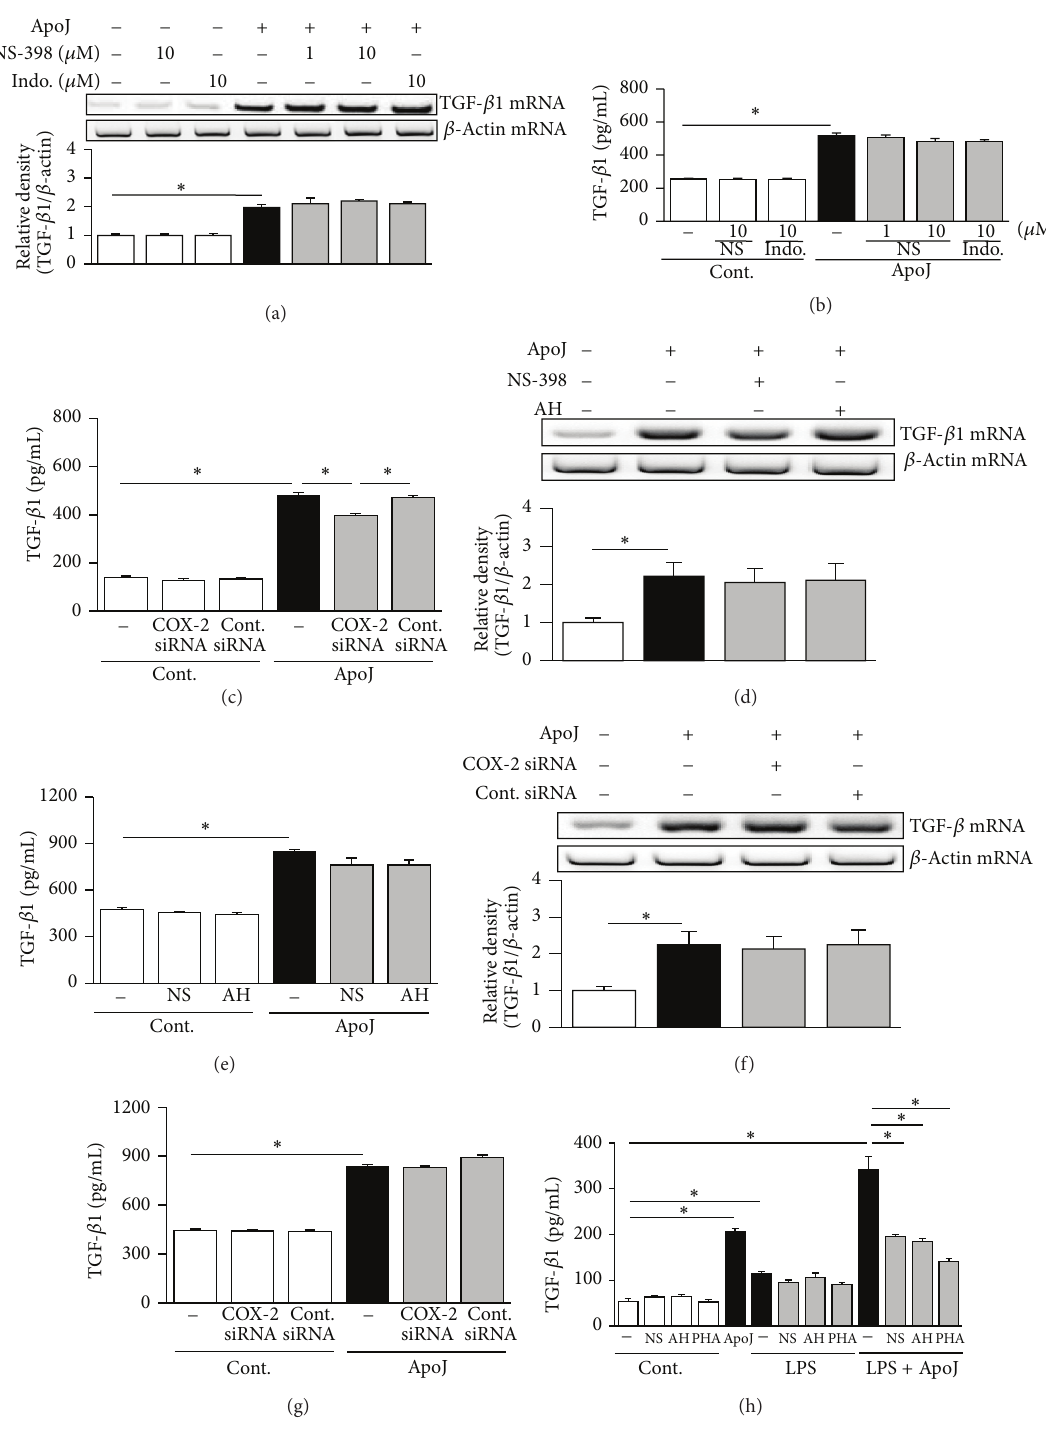
Figure 8: TGF- 𝛽 1 induction in unstimulated macrophages in response to apoptotic cells is not notably suppressed by COX-2 inhibition. RAW 264.7 cells (a, b) or peritoneal macrophages (d, e) were pretreated with NS-398, indomethacin (Indo), or AH-6809 (AH) for 1h and then stimulated with apoptotic Jurkat cells (ApoJ) for 2 h to detect TGF- 𝛽 1 mRNA expression (a, d) or for 24 h to detect secreted TGF- 𝛽 1 (b, e). RAW cells (c) or peritoneal macrophages (f, g) were transfected with COX-2 siRNA or control vehicle (siRNA-GFP) for 6h and then stimulated with ApoJ for 2h to detect TGF- 𝛽 1 mRNA expression, or for 24 h to detect secreted TGF- 𝛽 1. (h) Raw cells were pretreated with 10 𝜇 M NS-398, 10 𝜇 M AH-6809, or 10 𝜇 M PHA-665752 for 1h and then stimulated with 1 𝜇 g/mL LPS and ApoJ. (a, d, f) TGF- 𝛽 1 mRNA levels were analyzed using semiquantitative RT-PCR and normalized to 𝛽 -actin mRNA levels. (b, c, e, g, h) TGF- 𝛽 1 levels in conditioned media were measured by ELISA. Values represent mean ± SEM of three or more separate experiments; ∗ 𝑃 < 0.05